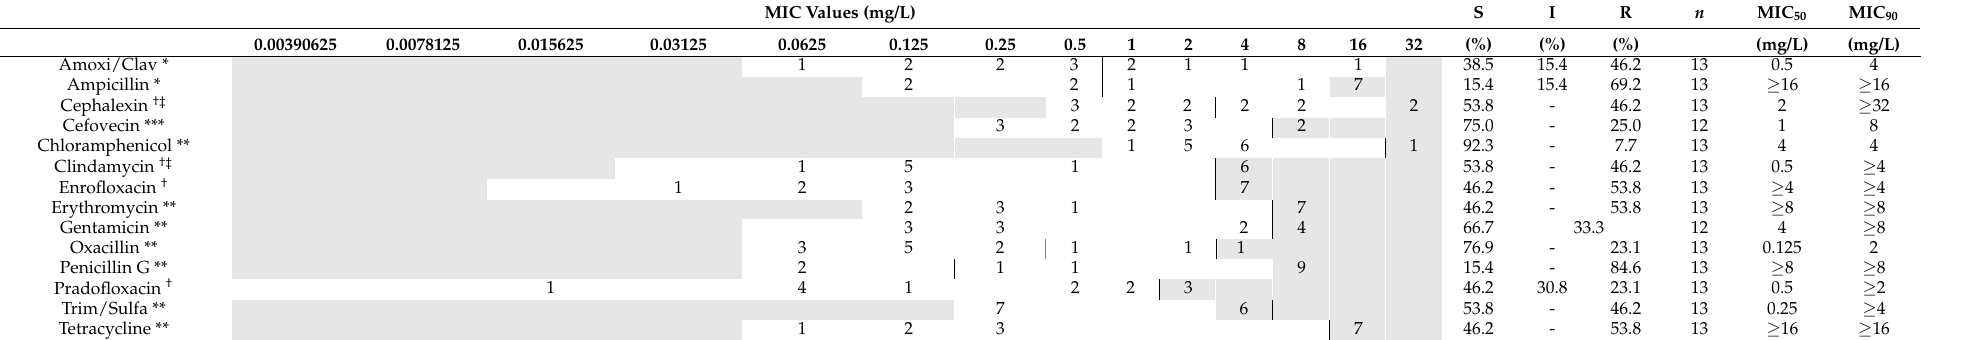
Table 7. Activity of various antimicrobials against coagulase-positive staphylococci (CoPS) isolates cultured from cats with urinary tract